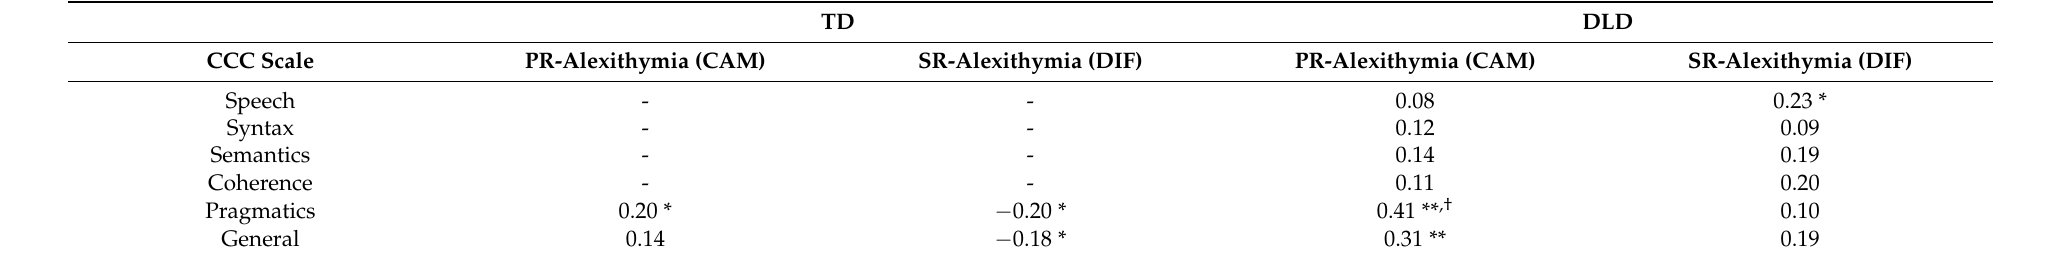
Table 3. Correlations between parent and child-report alexithymia measures and subscales of the